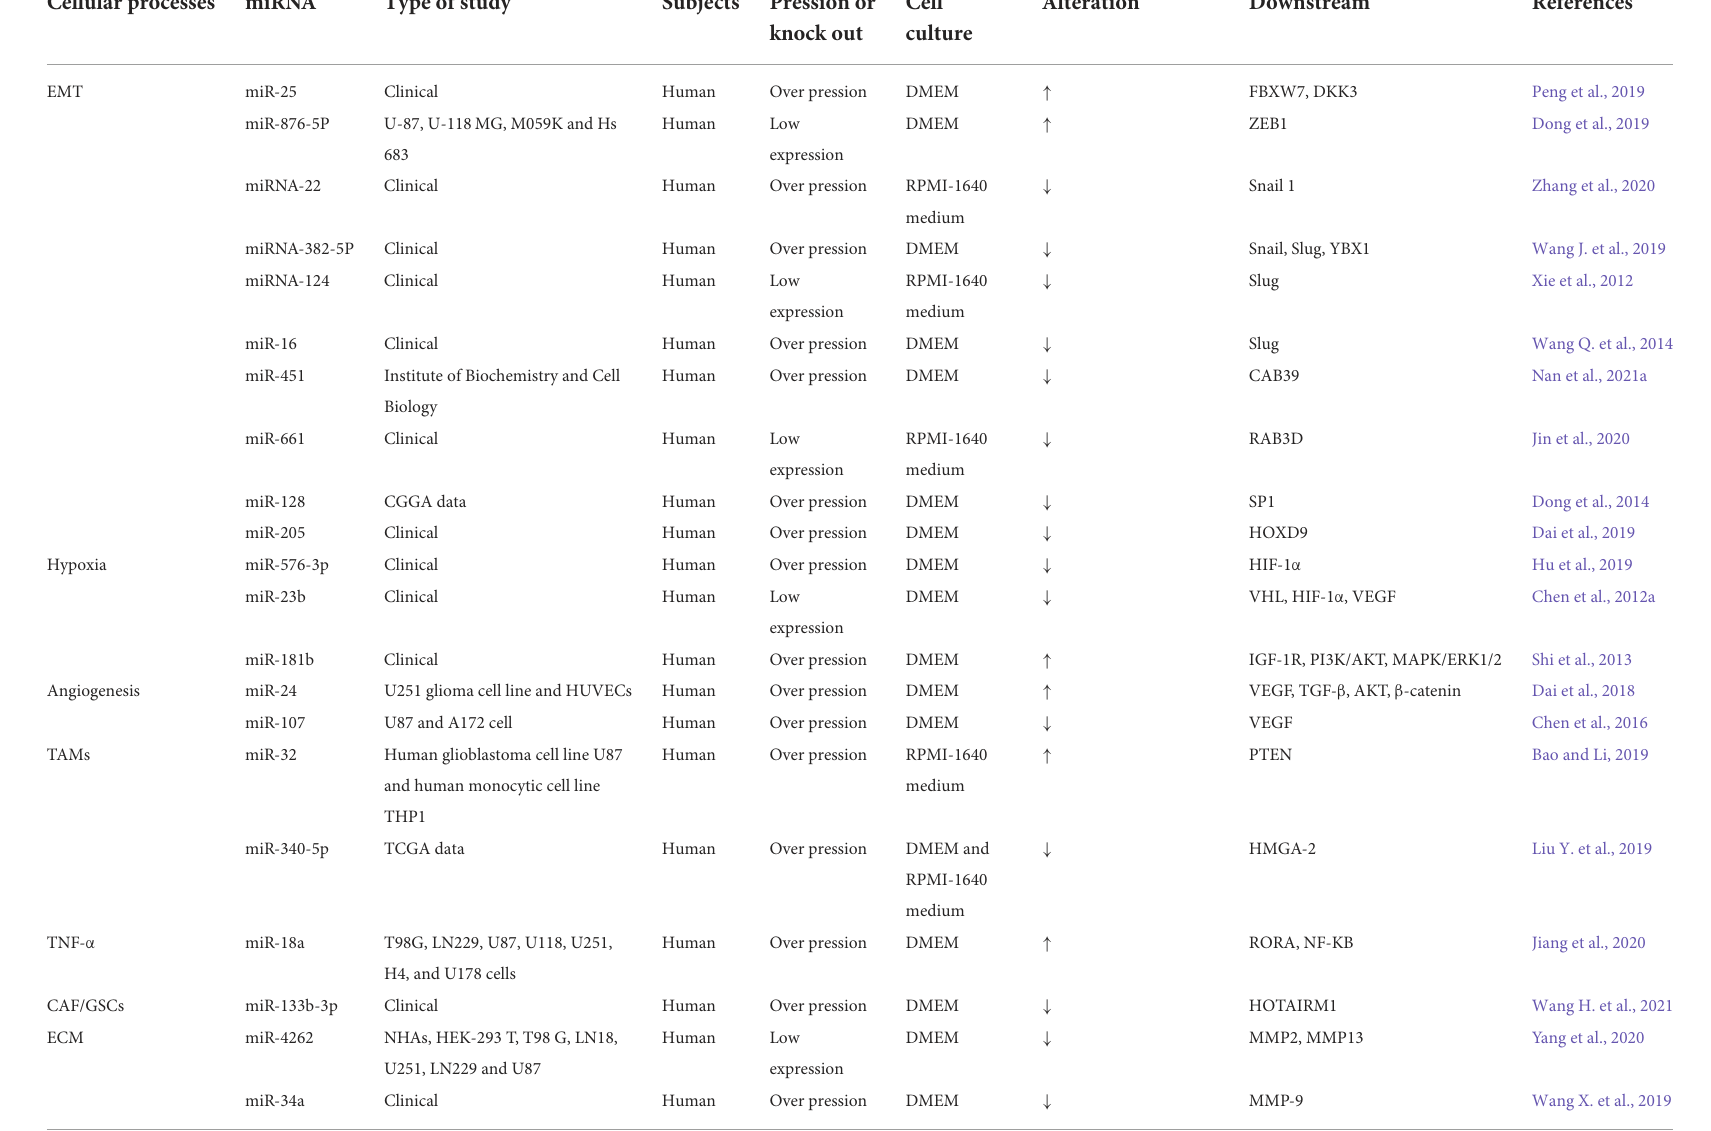
TABLE 1 Cellular processes related to miRNA in glioma migration and